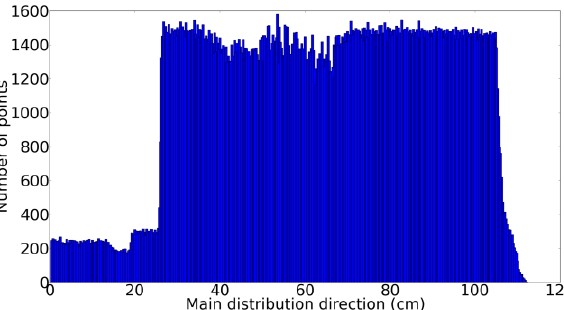
Figure 9. Histogram of a segment containing a circuit breaker